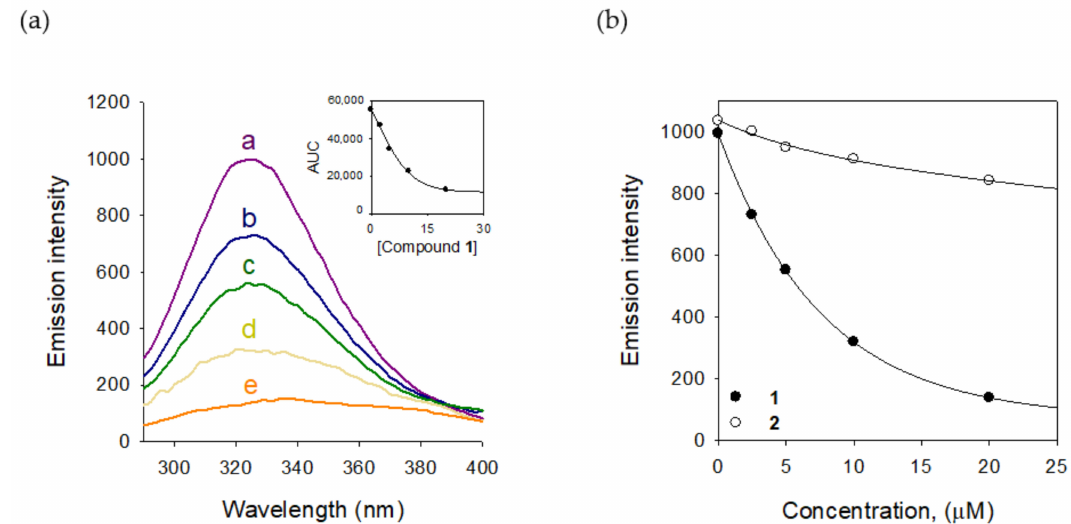
Figure 6. ( a ) The fluorescence emission spectra of tyrosinase at di ff erent concentrations of compound 1 (0, 2.5, 5, 10, and 20 µ M for curves a → e) (Inset) Normalized intensities of the fluorescence for tyrosinase are shown for compound 1 . ( b ) Decrease in intensity of the emission plots for compounds 1 and 2